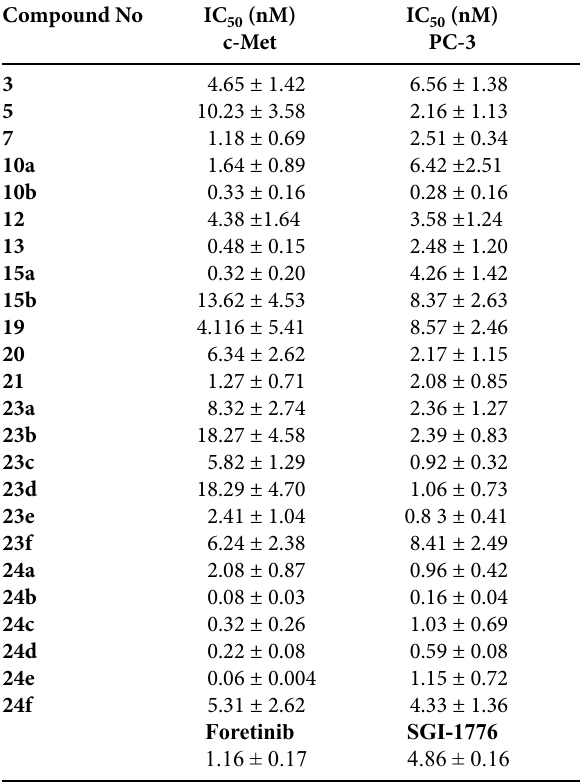
Table 2 . c-Met enzymatic activity of the newly synthesized com- pounds.